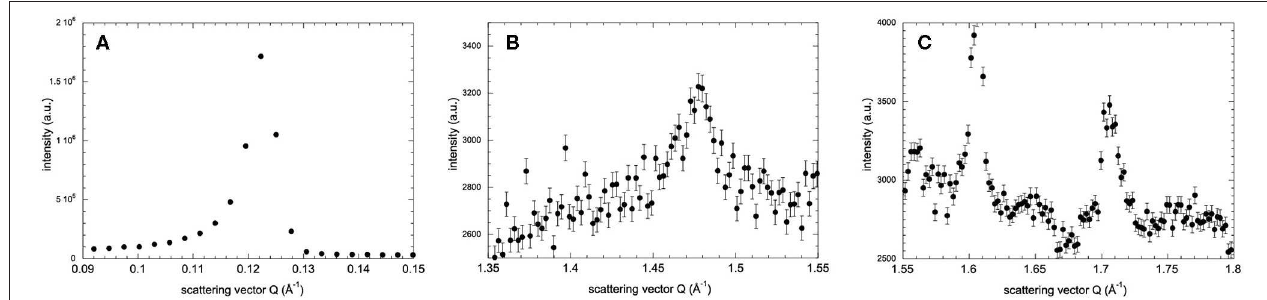
FIGURE 1 | Neutron diffraction intensity of hydrated DMPC lipid stacks at 260K as a function of the scattering vector Q in three different Q -ranges. Diffraction peaks originate from (A) the lamellar spacing, (B) in-plane lipid ordering, and (C) crystalline water ice. In (C) , the peaks at Q = 1.61 Å − 1 and Q = 1.71 Å − 1 are called ice peak 1 and ice peak 2 , respectively. Diffraction intensities in all three q -ranges have been recorded after flash cooling upon heating from 100 to 300K (SHFC protocol). Error bars in (B,C) correspond to sqrt( N ( x , y ))/ t , where N ( x , y ) are the total counts in pixels x , y of the detector and t is the acquisition time. In (A) , the error bars are too small to be seen.